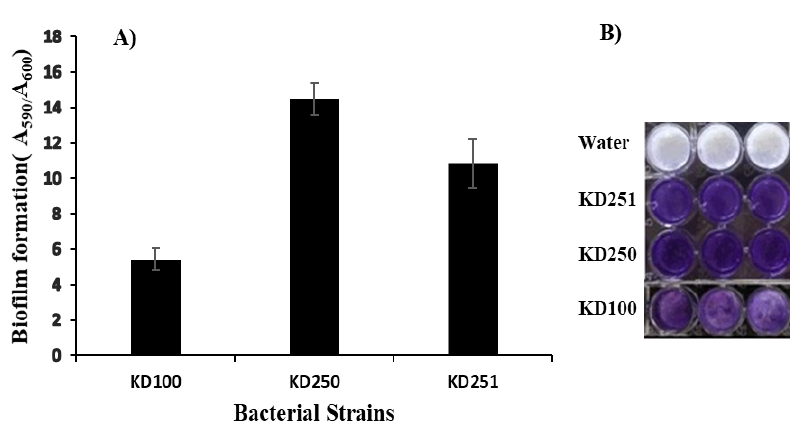
Figure 10. ( A ) Quantitative detection of biofilm formation in polystyrene 96-well plates. Biofilm formation was determined using the absorbance ratio of A 590 and A 600 . ( B ) Visualization of biofilm formation by crystal violet staining. Biofilm in microtiter wells were observed with crystal violet staining after incubation of bacterial strains for 20 h at 28 °C (More than three microtiter wells were used to quantify biofilm production for each bacterial strain, Values are the mean ± standard deviation).